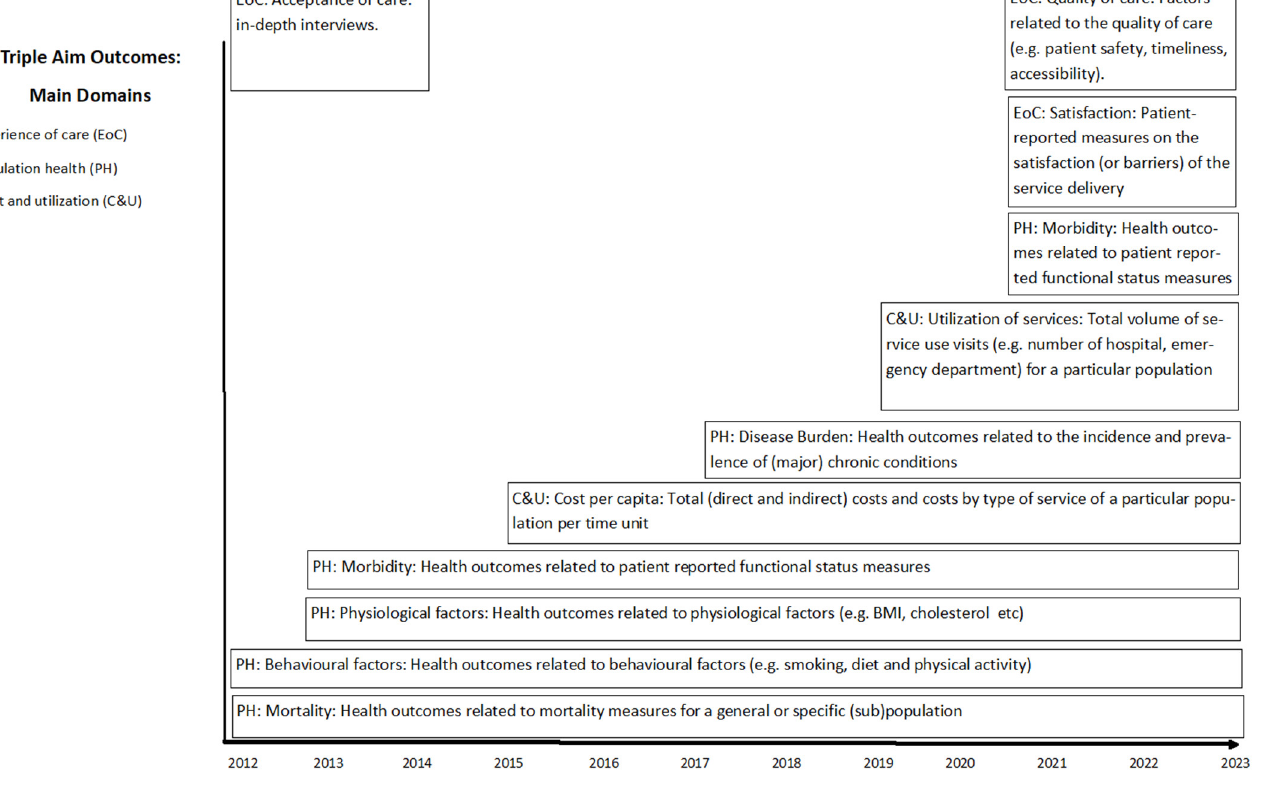
Table 1. Outcome measures used to evaluate the ICM within the first year of use and the type of instrument. Summary based on publications referring to ICM and internal ICM data [25–28,32].